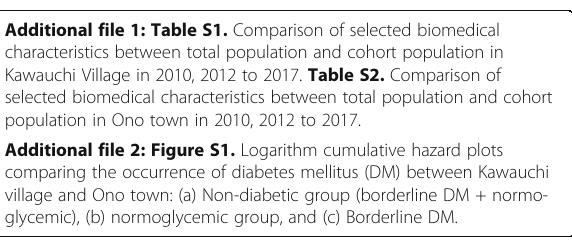
Additional file 1: Table S1. Comparison of selected biomedical characteristics between total population and cohort population